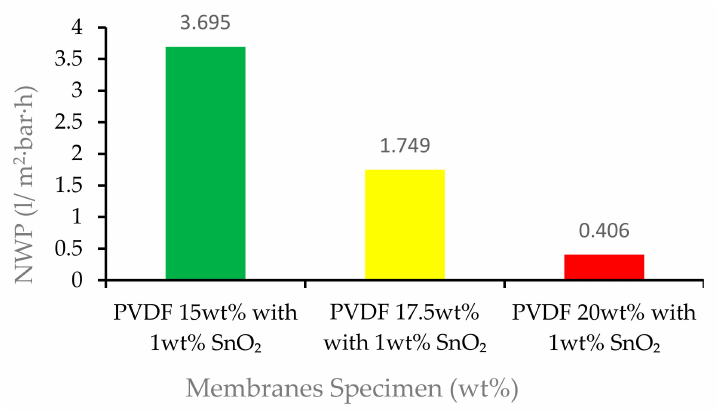
Figure 10. Average NWP of 15 wt%, 17.5 wt%, and 20 wt% PVDF with 1% tin dioxide